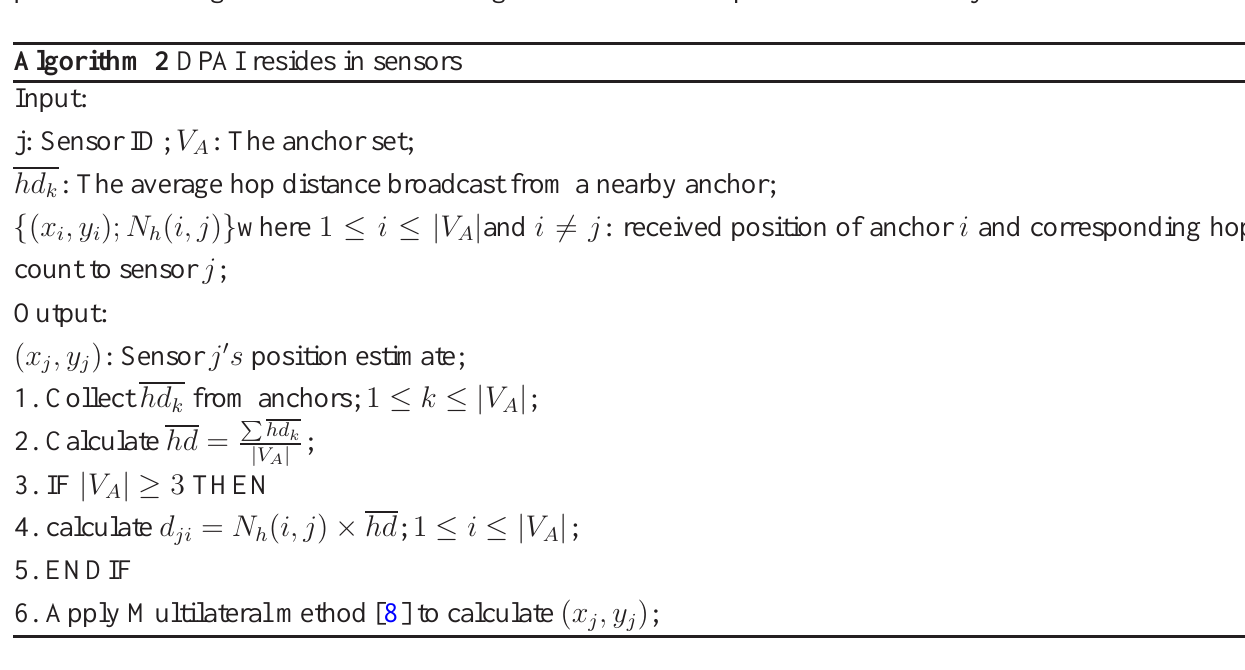
Algorithm 2 DPAI resides in sensors